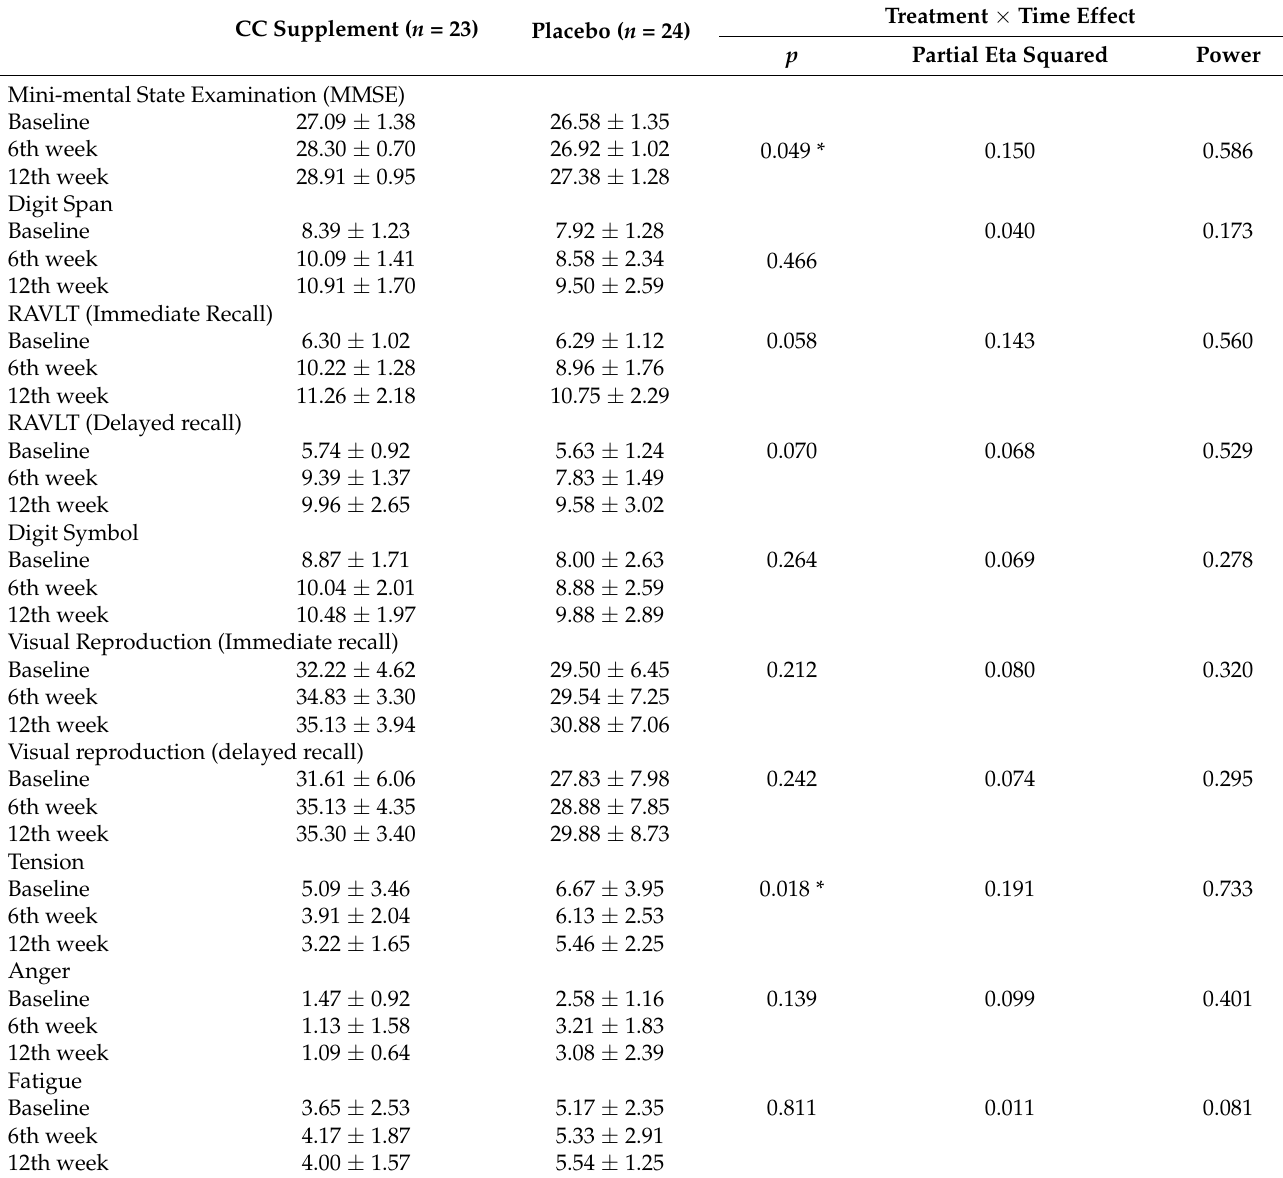
Table 4. Intervention effect of cognitive function and mood state from baseline to 12th